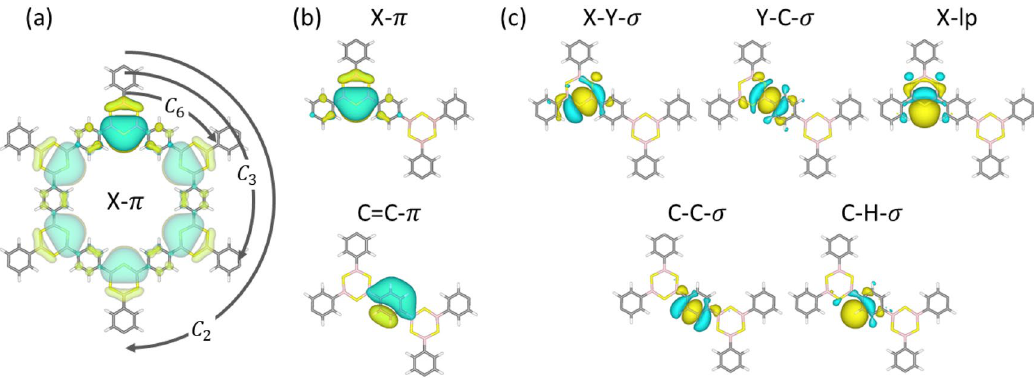
Figure 4. Illustration of Wannier orbitals obtained for all materials. ( a ) The symmetry equivalent WO of the type X- π . ( b , c ) All different bond-types in terms of WO at linker and phenyl rings. The notation of WO is based on the atom types (X,Y,C,H) and shapes ( π , σ , lp). All studied COFs contain the same shapes of